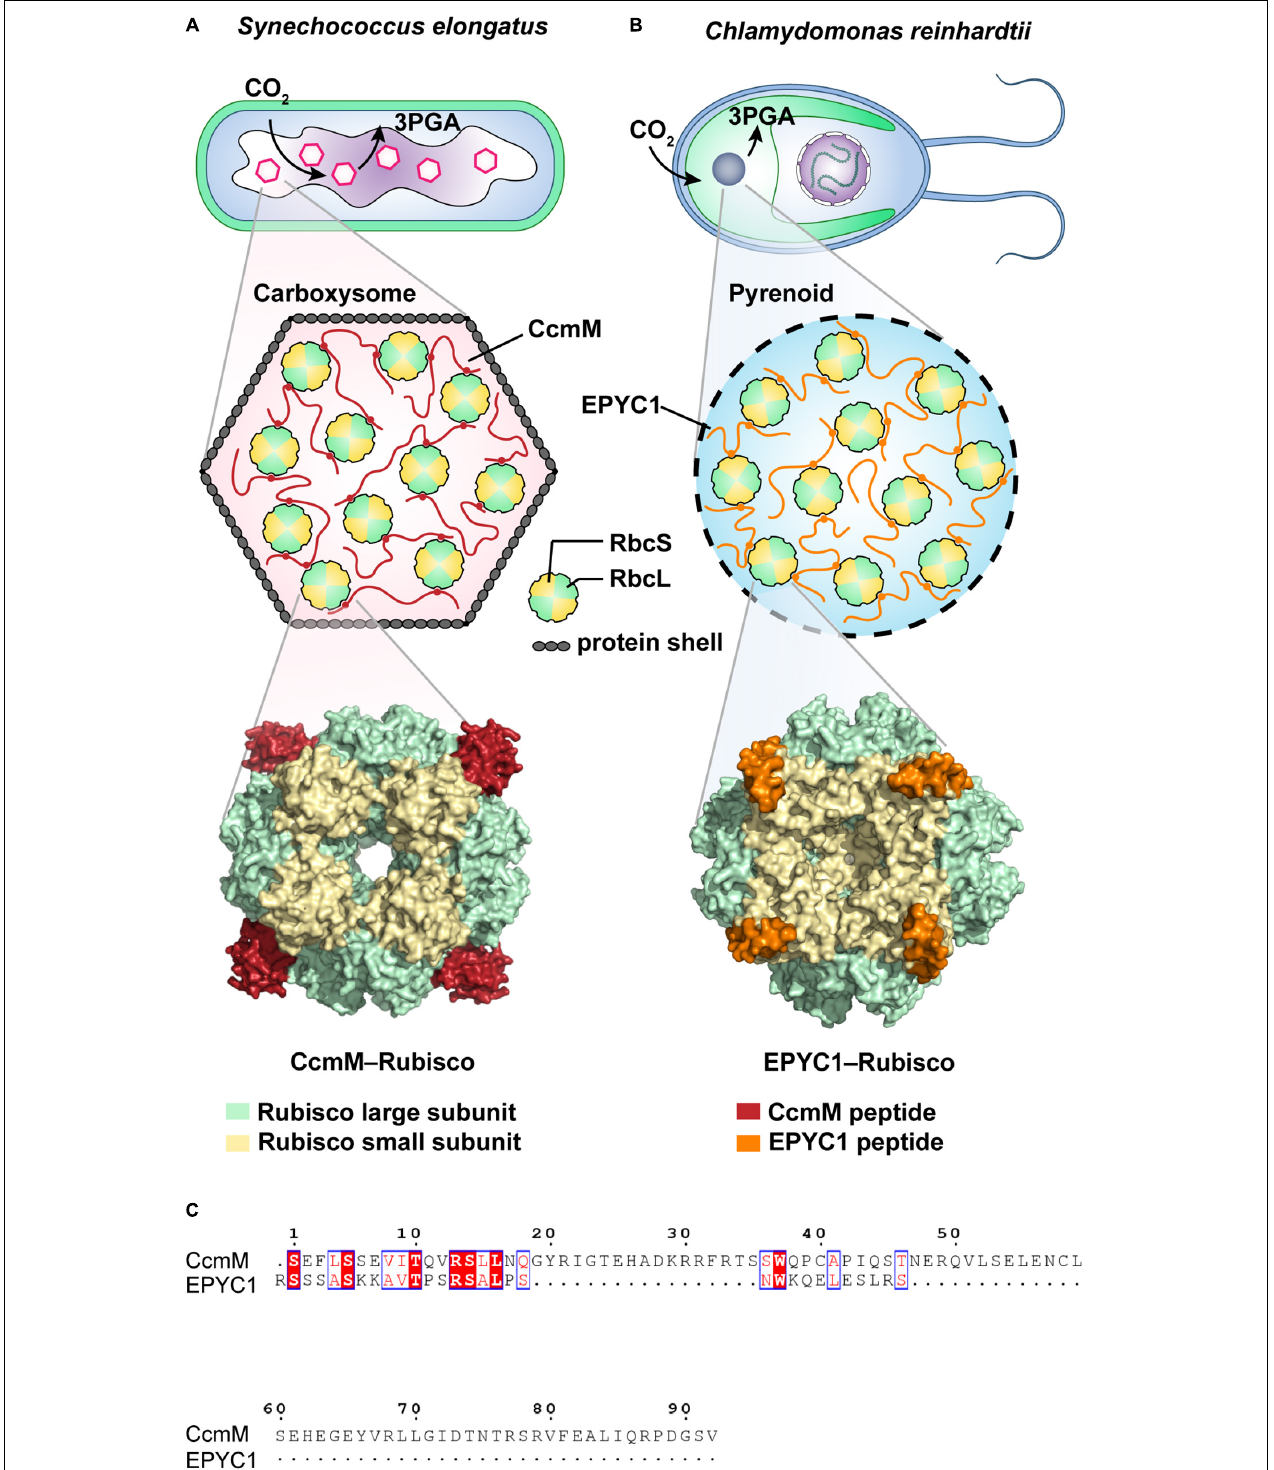
FIGURE 3 | Schematic illustrations of CO 2 -fixing phase-separated liquid organelles in prokaryotic or eukaryotic cells. (A) Carboxysome-based Rubisco condensate found in the prokaryotic cyanobacterium Synechococcus elongatus PCC7942. As a scaffold protein, CcmM peptide (red) binds the Rubisco large subunit (RbcL, green) and Rubisco large subunit (RbcS, yellow) via salt bridges and van der Waals contacts to form the CcmM-Rubisco complex. It includes the condensates in the